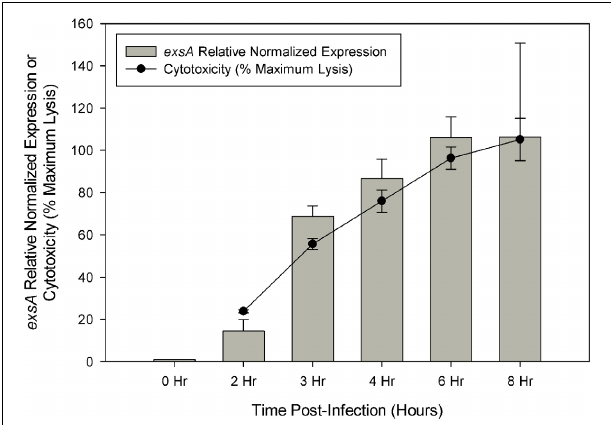
FIGURE 1 | Quantitive RT-PCR was used to determine the relative expression of exsA during HeLa cell infection. Relative expression at each time point was determined by comparison with 0h (pre-infection) using the (cid:2)(cid:2) Ct method with secY as the control transcript. Cytotoxicity was assessed by LDH release at specified time points during HeLa cell infection and calculated as a percentage of maximum lysis (see Materials and Methods). Each measurement represents the average of two independent replicates, and error bars represent